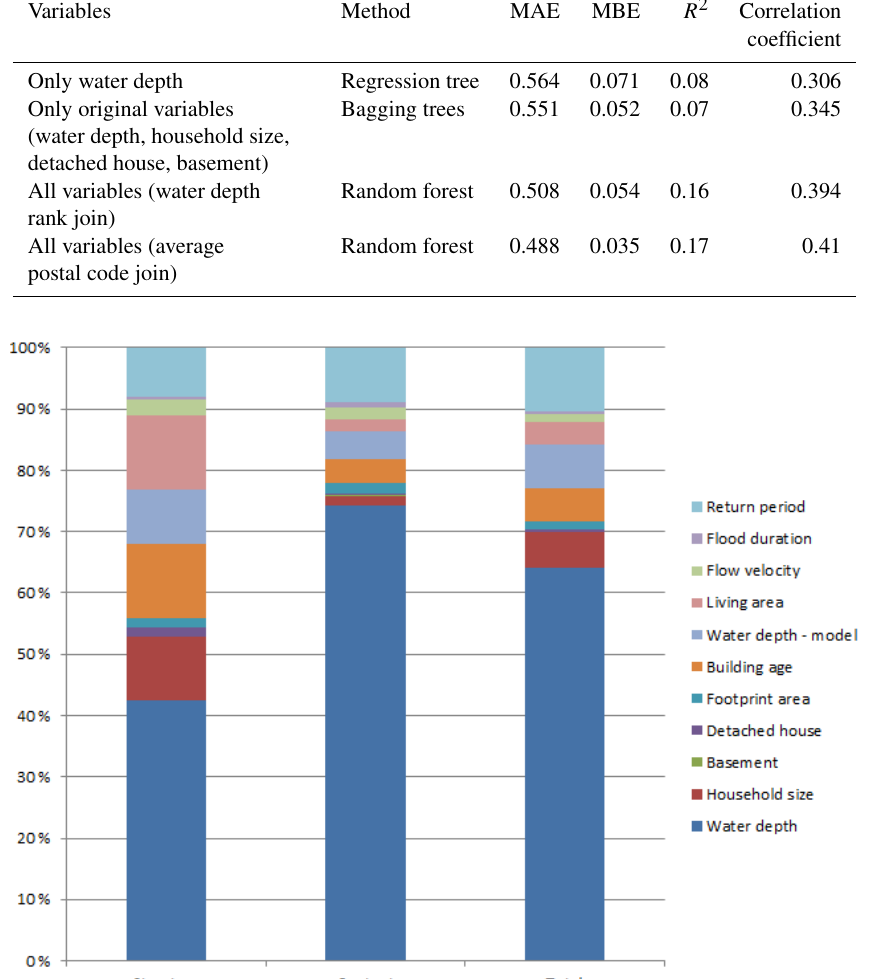
Figure 5. Variable importance: the contribution of different variables in reducing the error in the bagging regression trees (the chart follows the order of the